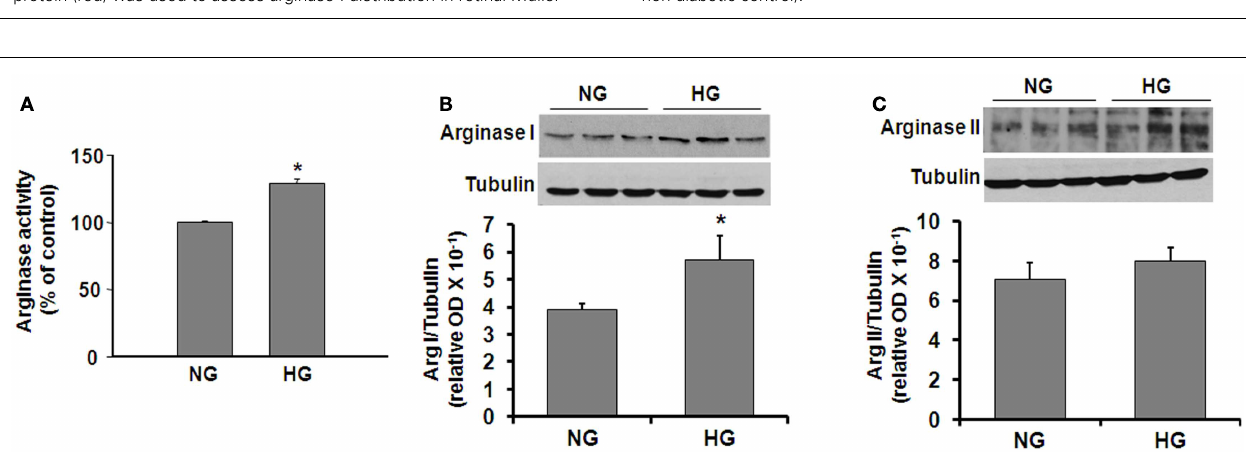
FIGURE 1 | Diabetes-induced increases in retinal arginase protein and activity levels. Mice were rendered diabetic with STZ and sacrificed after 2months. (A) Retinal arginase I and II protein distribution were examined by immunofluorescence imaging. Scale bar = 50 µ M. (B) Double label of arginase I (green) and cellular retinaldehyde binding protein (red) was used to assess arginase I distribution in retinal Müller